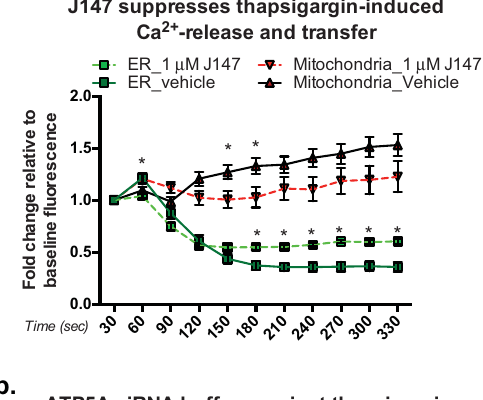
mitochondrial Ca 2 + after thapsigargin treatment was also decreased in ATP5A knockdown cells (red symbols, solid vs. dotted lines). These data show that J147 has an ER-speci fi c effect on Ca 2 + maintenance, and point to mitochondrial involvement in the maintenance of ER Ca 2 + stores as a way to regulate SOCE.